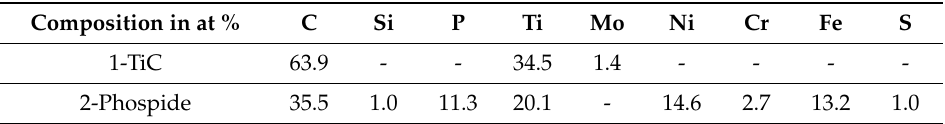
Figure 12. Extracted precipitates showing ( 1 ) the morphology of a TiC as a thin flake and ( 2 ) a phosphide with an irregular cellular form. Table 3. EDX analysis on extracted particles.